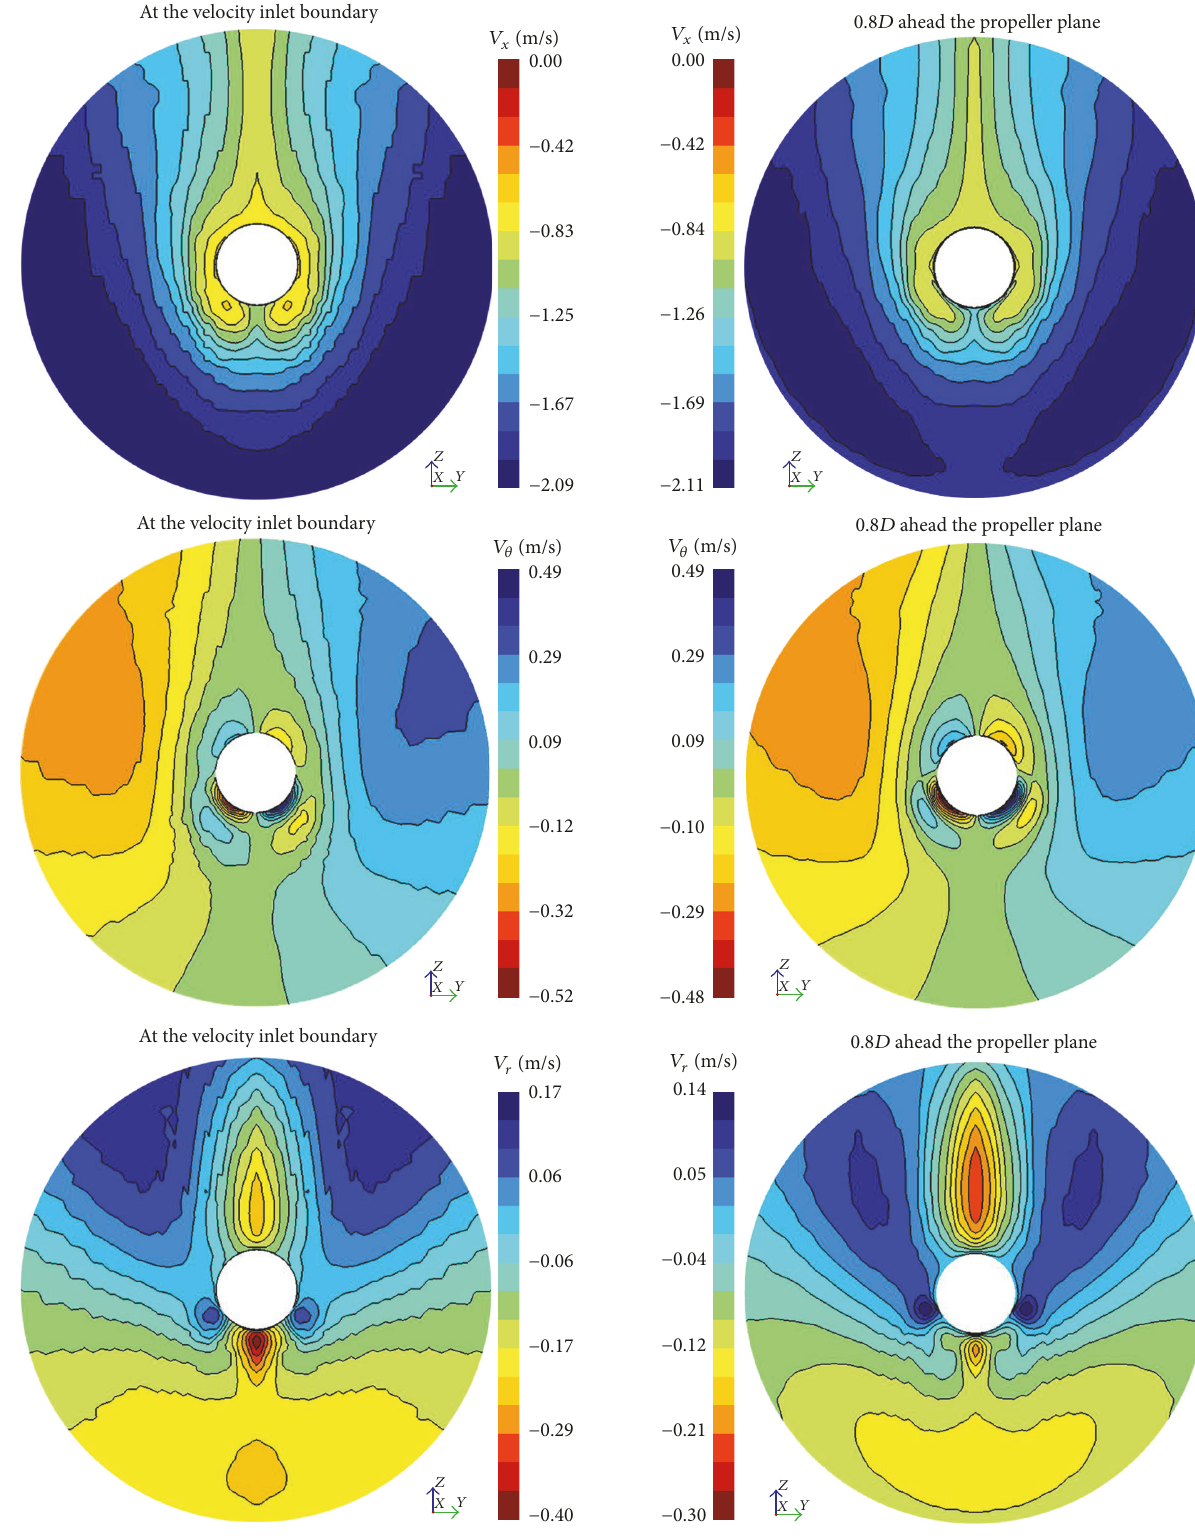
Figure 21: Velocity distributions at the velocity inlet boundary and a section plane 0.8𝐷 upstream of the propeller